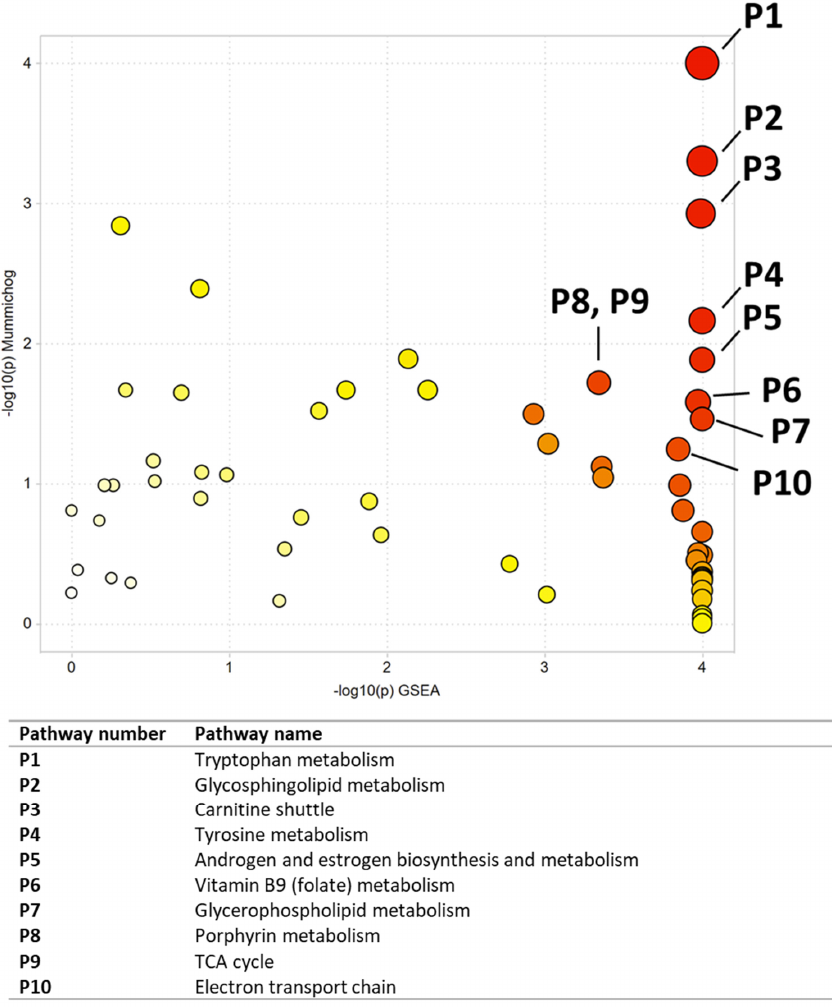
Figure 7. Pathway analysis results comparing NNK and vehicle-treated CAL27 cells. All significant pathways are listed in Table 7. Darker circles represent pathways with a lower p -value. Larger circles indicate a higher number of significant metabolite hits relative to the total pathway